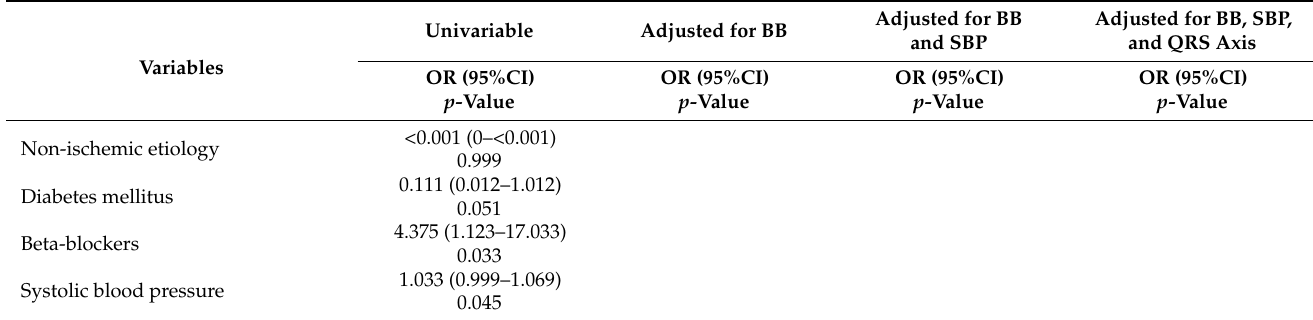
Table 2. Logistic regression analyses of echocardiographic